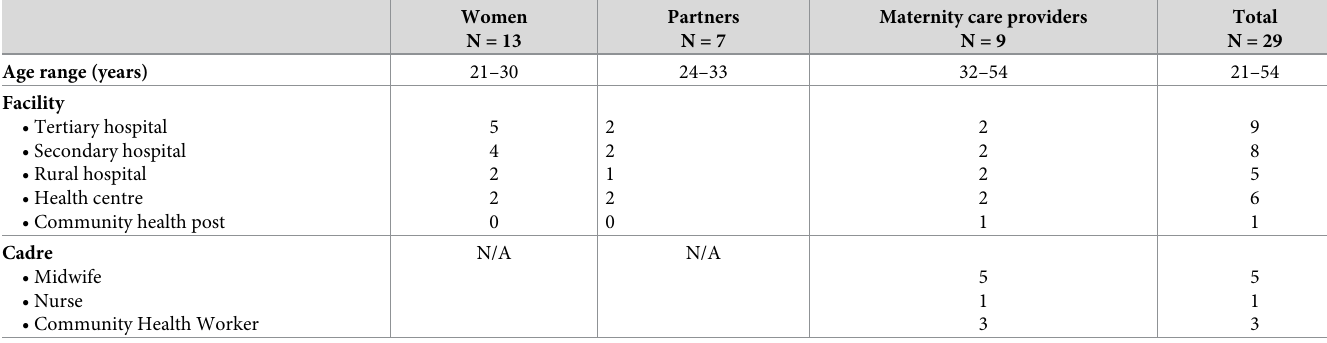
Table 1. Sociodemographic characteristics of interview